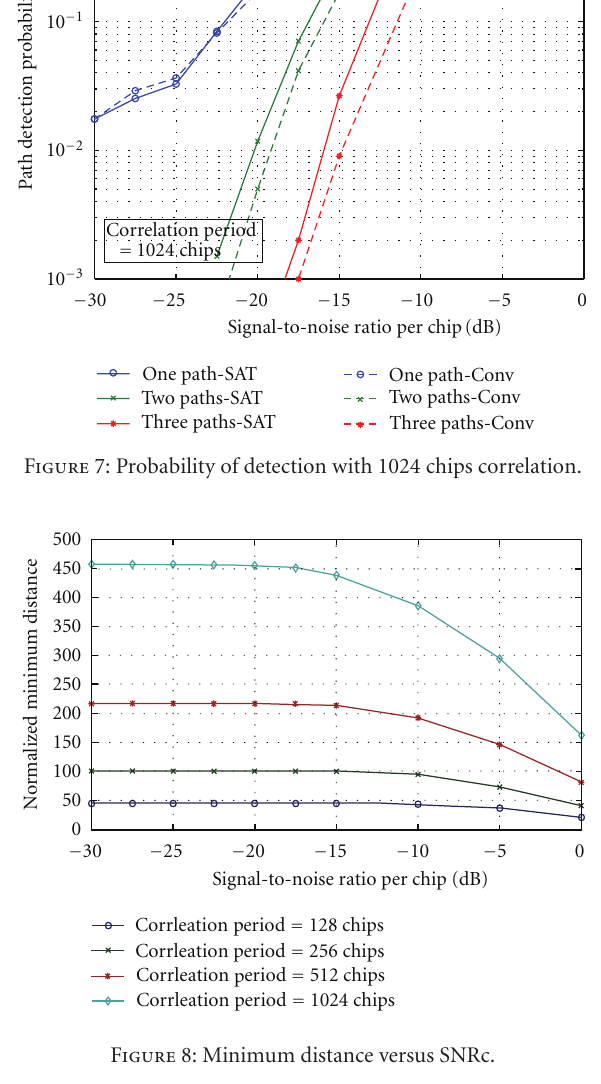
Figure 6: Probability of detection with 512 chips correlation.